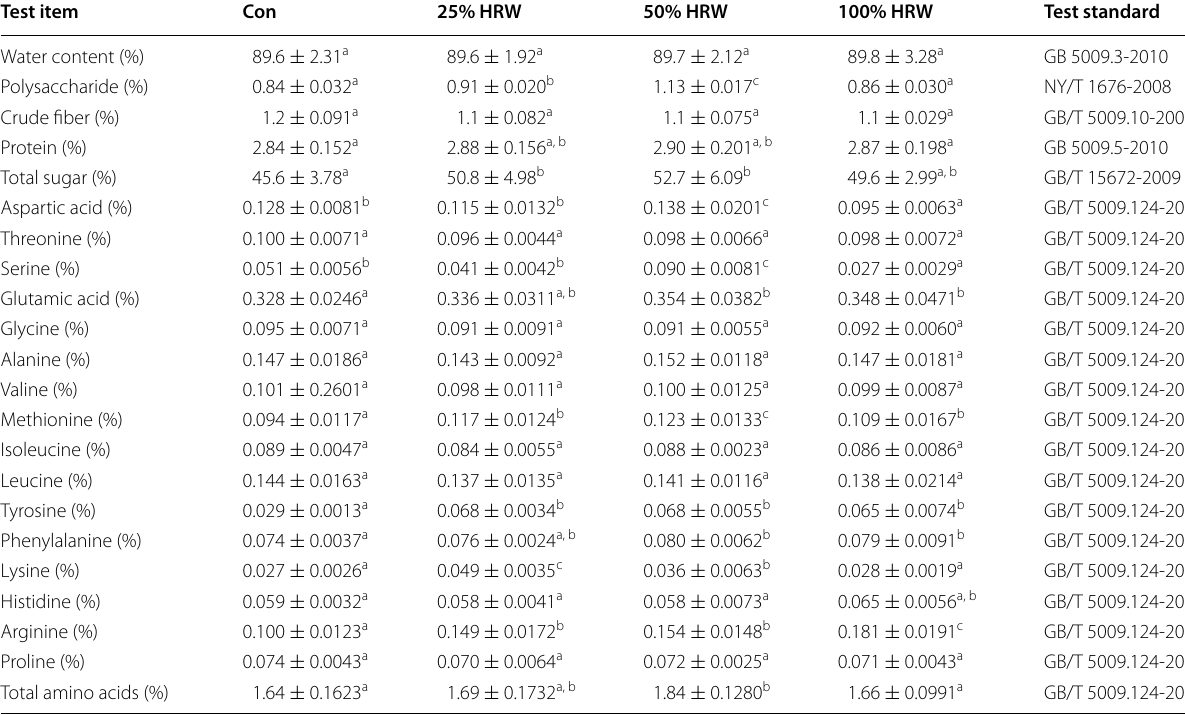
The lowercase letters denote a statistically significant difference compared with the control according to multiple comparisons (P <